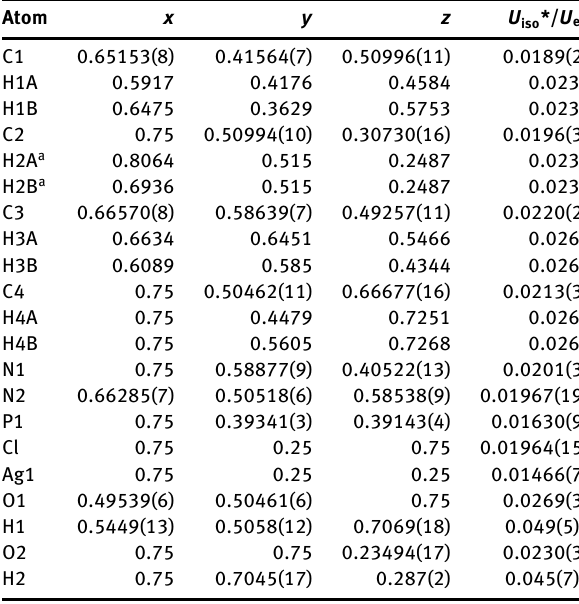
Table 2: Fractional atomic coordinates and isotropic or equivalent isotropic displacement parameters (Å 2